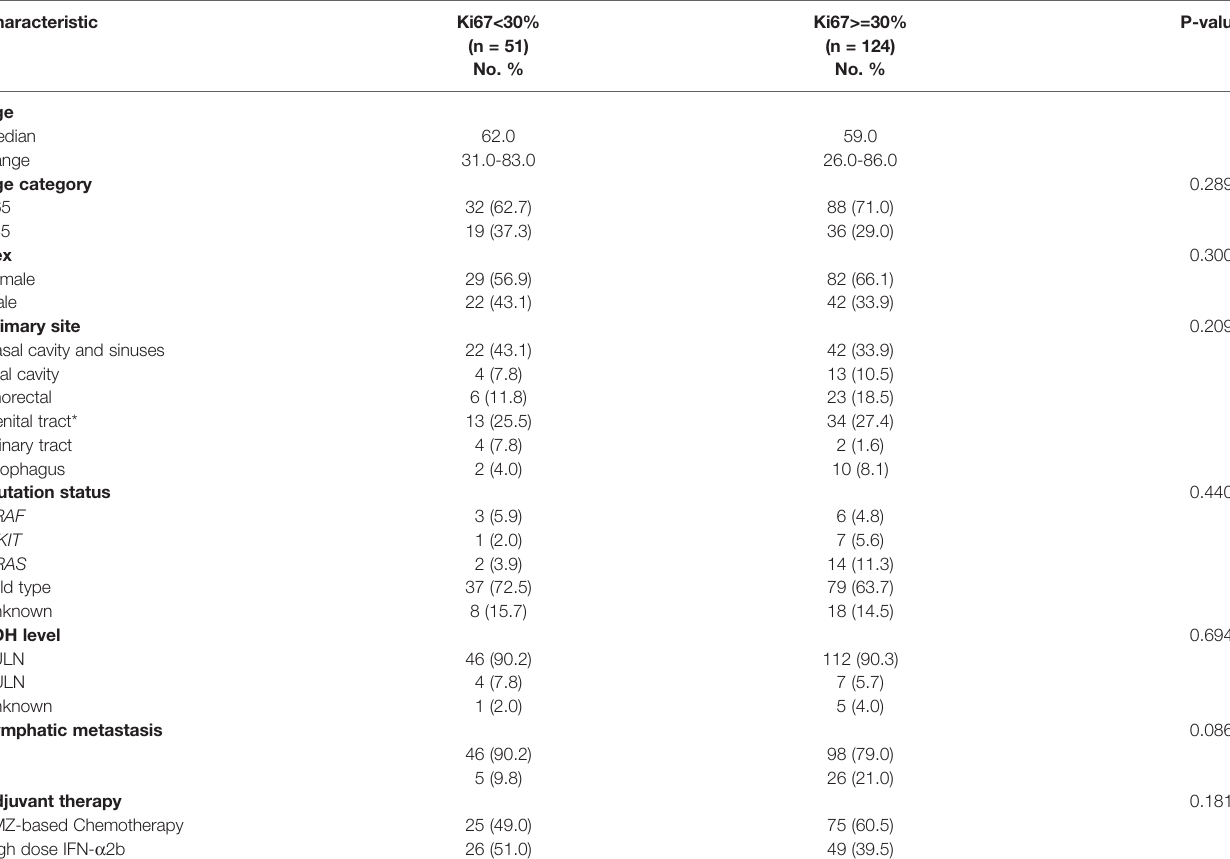
TABLE 2 | Clinical characteristics of each Ki67 group (<30% and